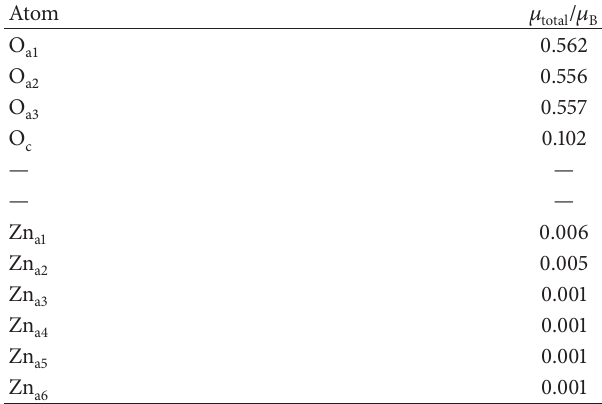
Table 2: Calculated Mulliken population of the ZnO nanowire with V Zn defect. Around the V Zn , the O ai represents the first-nearest neighboring O atoms in the basal plane, the O c is the second-nearest neighboring O atoms in the axial plane, and the Zn nearest neighboring Zn atoms in the basal